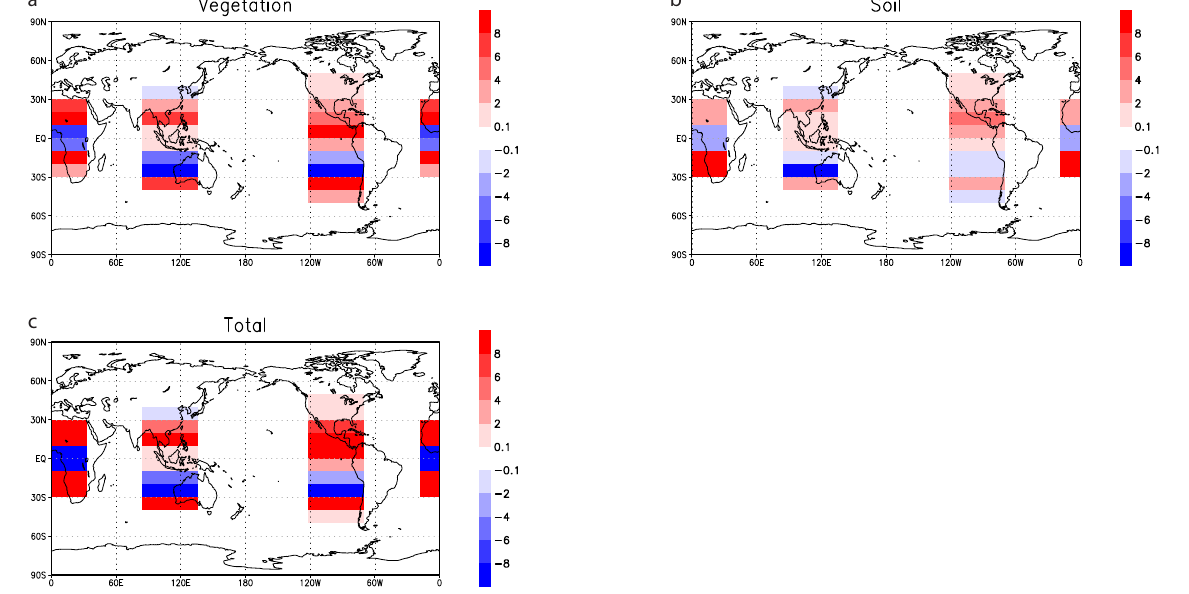
Fig. 7. Change of carbon content (GtC) in (a) the vegetation, (b) soil and (c) total for the simulation during the Preindustrial with a fresh water flux added in the North Atlantic of 0.5Sv during 400